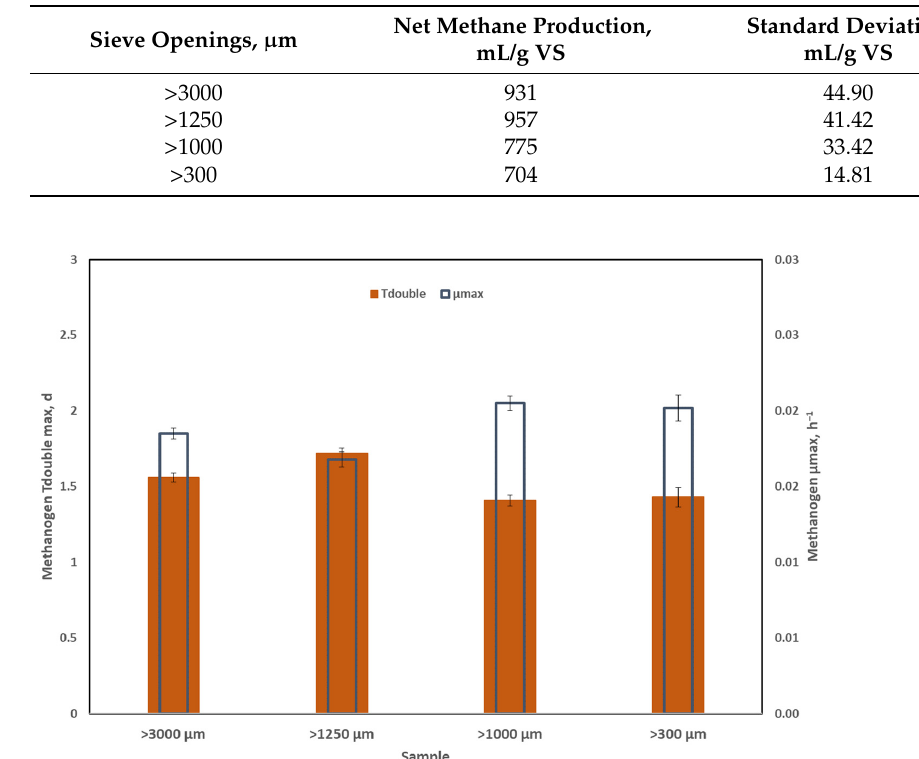
Figure 6. Maximum specific growth rate, µ max, and methanogen doubling time, Tdouble max, estimated from biochemical methane potential curves of cumulative solid samples collected from sieves with certain opening sizes.